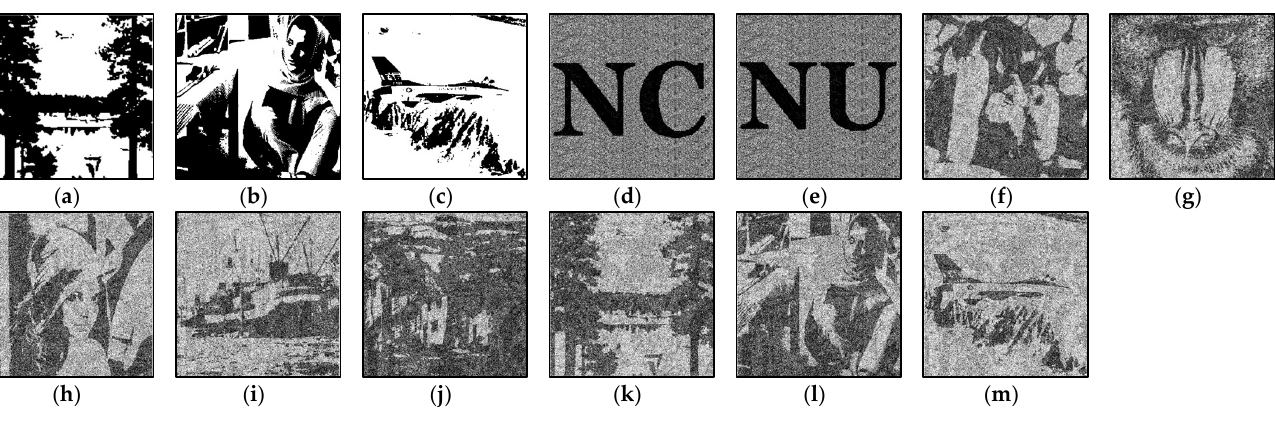
Figure 12. Experimental results by Method 4 for (5, 5) with p = 45, γ = 0.5. ( a , b ) Restored images R 0 , R 1 ( c )–( g ) Shares M 0 , …, M 4 .